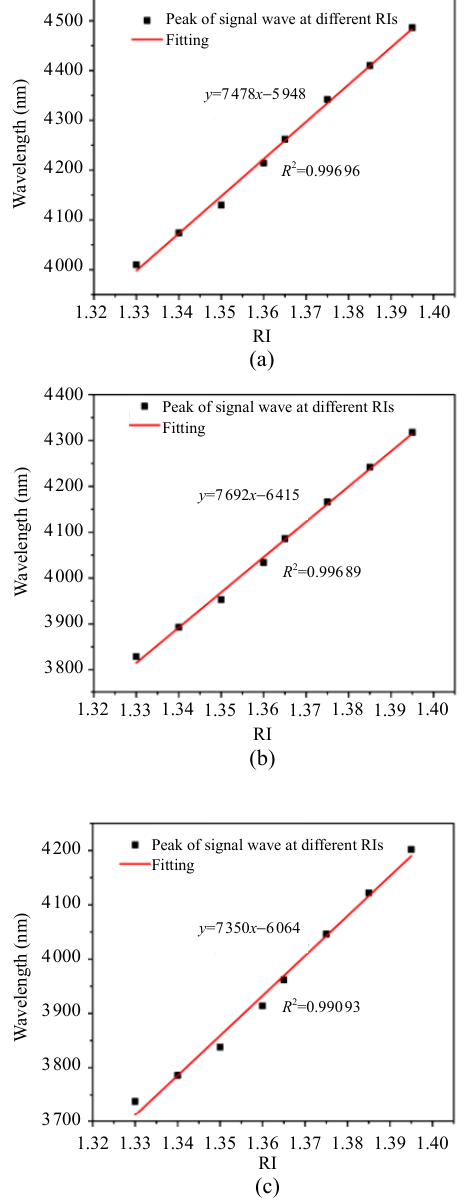
Fig. 6 Signal waves as a function of RI at (a) 3 370 nm, (b) 3 380 nm, and (c) 3 390 nm.